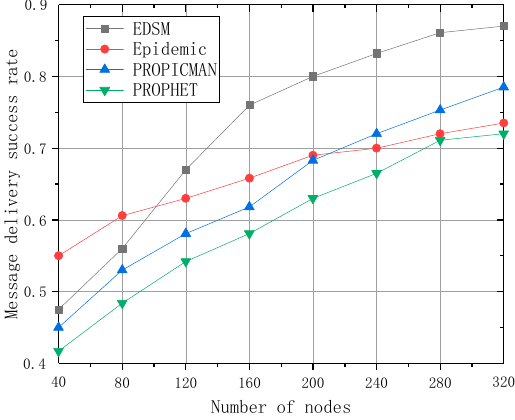
Figure 4. Message delivery rate under different number of nodes.